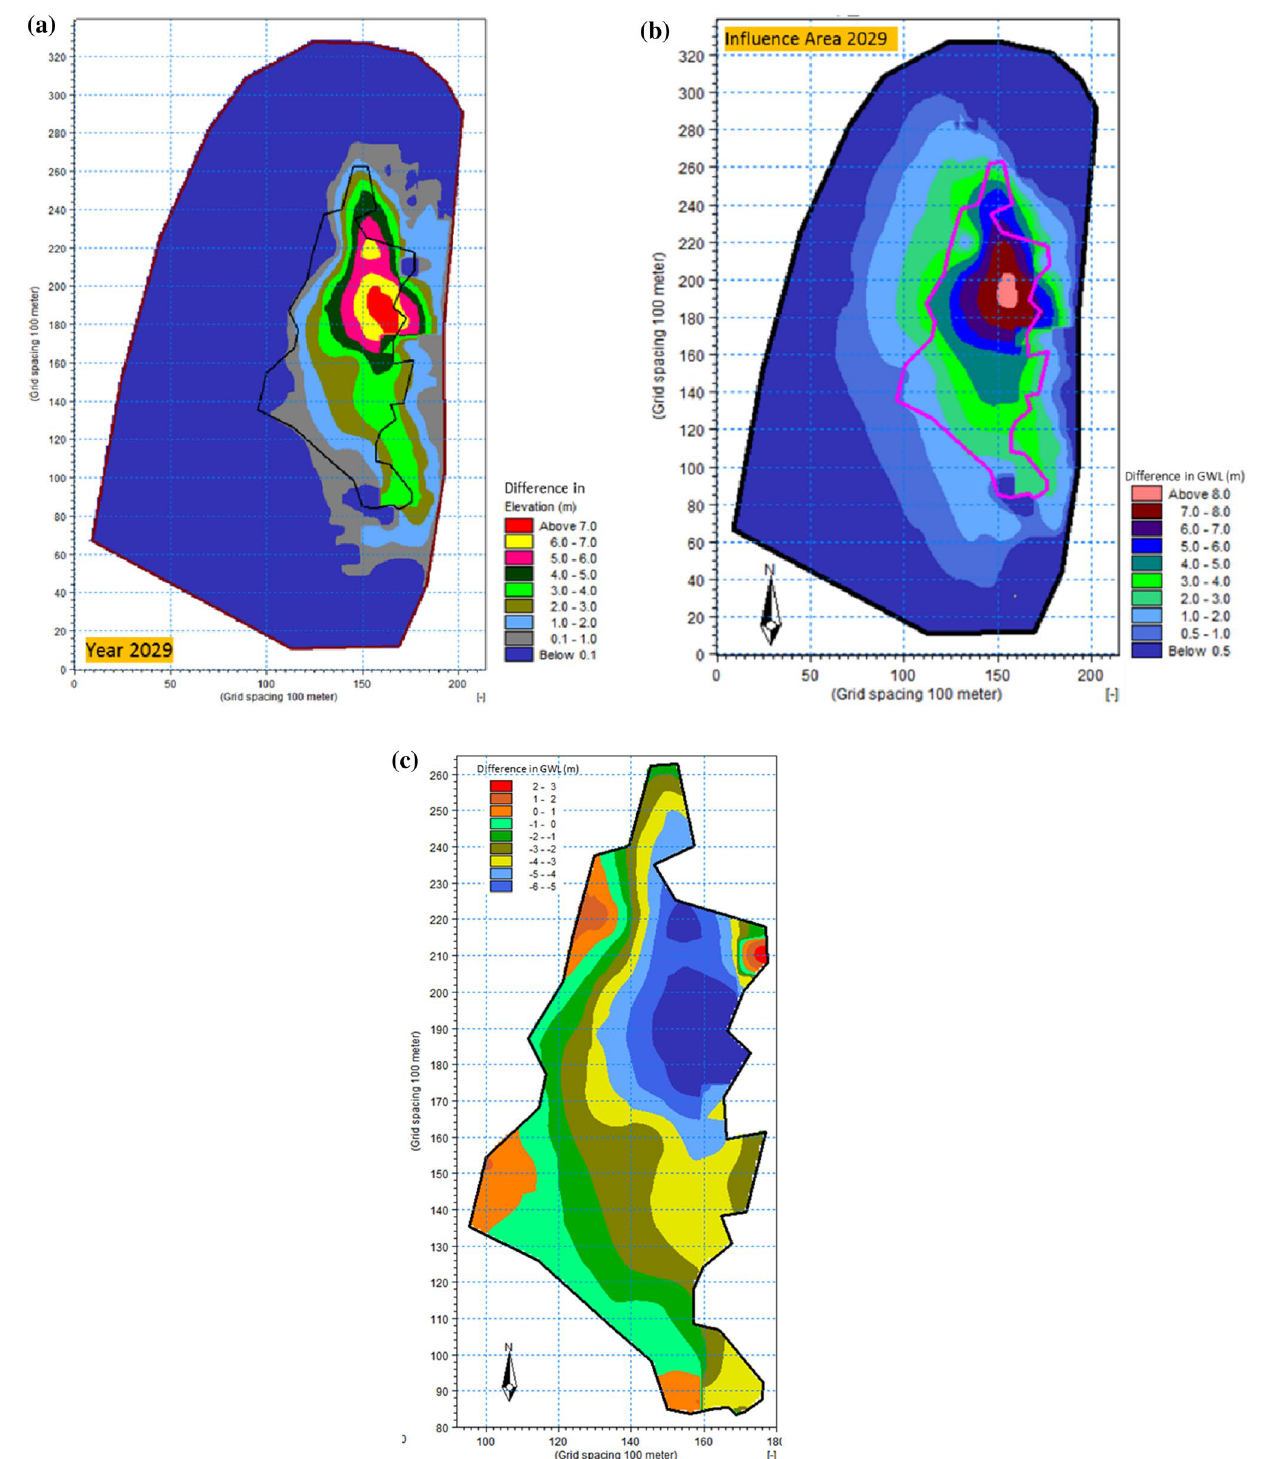
Fig. 13 a The area (approx. 141 km 2 ) where groundwater level on May 27, 2029 for scenario-2 is higher than scenario-0, b the area (approx 242 km 2 ) where the groundwater level is higher for sce- nario-2 than scenario-1 on May 27, 2029, and c the difference of